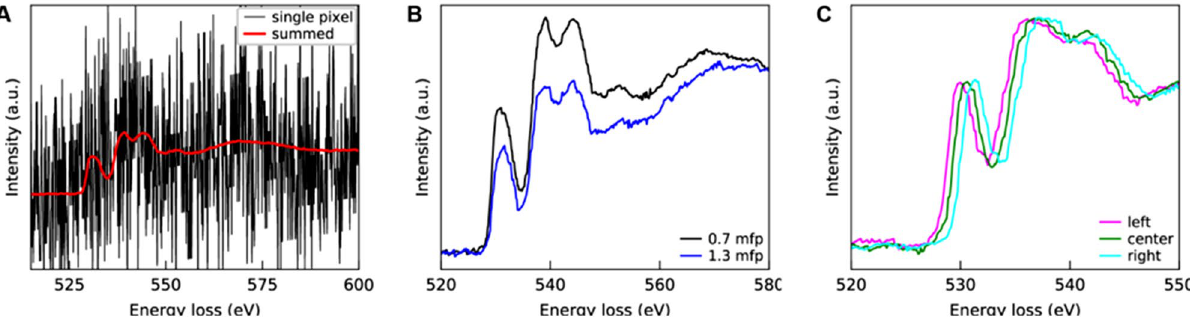
Figure 2. ( A ) Comparison of mean versus single pixel, centered at the same region of the sample. The single pixel values were multiplied by 4230 for comparison. ( B ) Effect of thickness of the initial state O K -edge. ( C ) Effect of spatial position of the STEM probe on the EELS energy shift. Scanning the STEM probe across the 600 nm SI box results in an energy shift of 1.5 eV. A power-law background subtraction was performed on all edges.